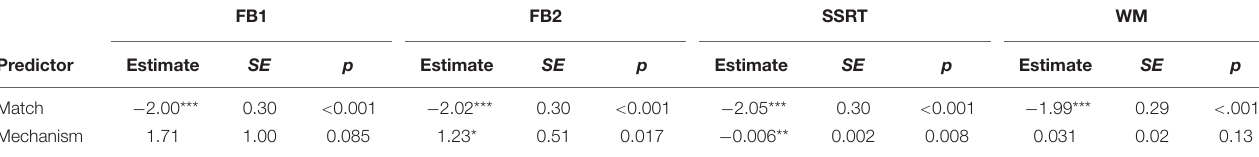
TABLE 5 | Estimated effects of Mechanism and Match on accuracy in object pronoun interpretation.